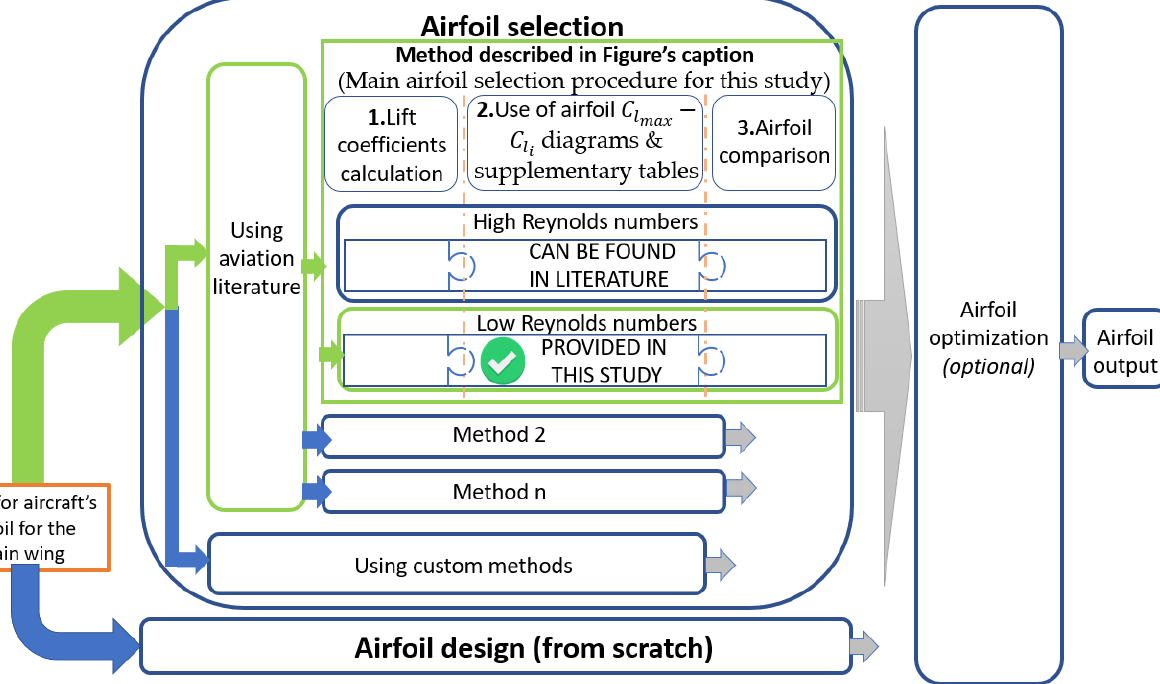
Figure 1. Possible routes to result with an aircraft airfoil and the exact spot of current’s study contribution. Main airfoil selection procedure for this study is based on [8,21].